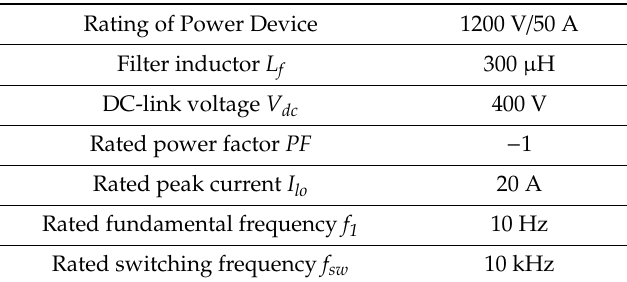
Table 1. Parameters and Rated Condition of Converter.